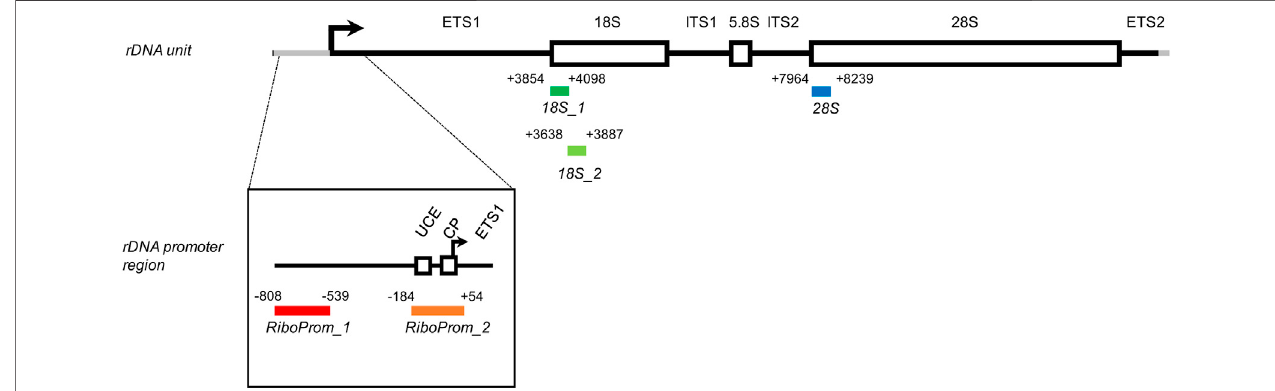
FIGURE 1 | Structure of the rDNA unit and localization of the target regions assessed in this study . Each amplicon included in the targeted-bisul fi te sequencing assay is encoded by its coordinates concerning therDNA unit (hg38, chr21:8292347 – 8222335). RiboProm_1 (red, from -808 to-539) is located on a distal promoterof the rDNA unit. RiboProm_2 (orange, from -184 to +54) is located on the proximal promoter ofthe rDNA unit and encompasses the upstream control element (UCE), the corepromoter(CP),andthetranscriptionstartingsite(indicatedbytheblackarrow).18S1(darkgreen,from+3854to+4098)and18S2(lightgreen,from+3638to +3887)arelocatedontothe5 ′ endofthe18Sgene.28S(darkblue,from+7964to8239)islocatedonthe5 ′ endofthe28Sgene.ETS:externaltranscribedspacer;ITS: internal transcribed